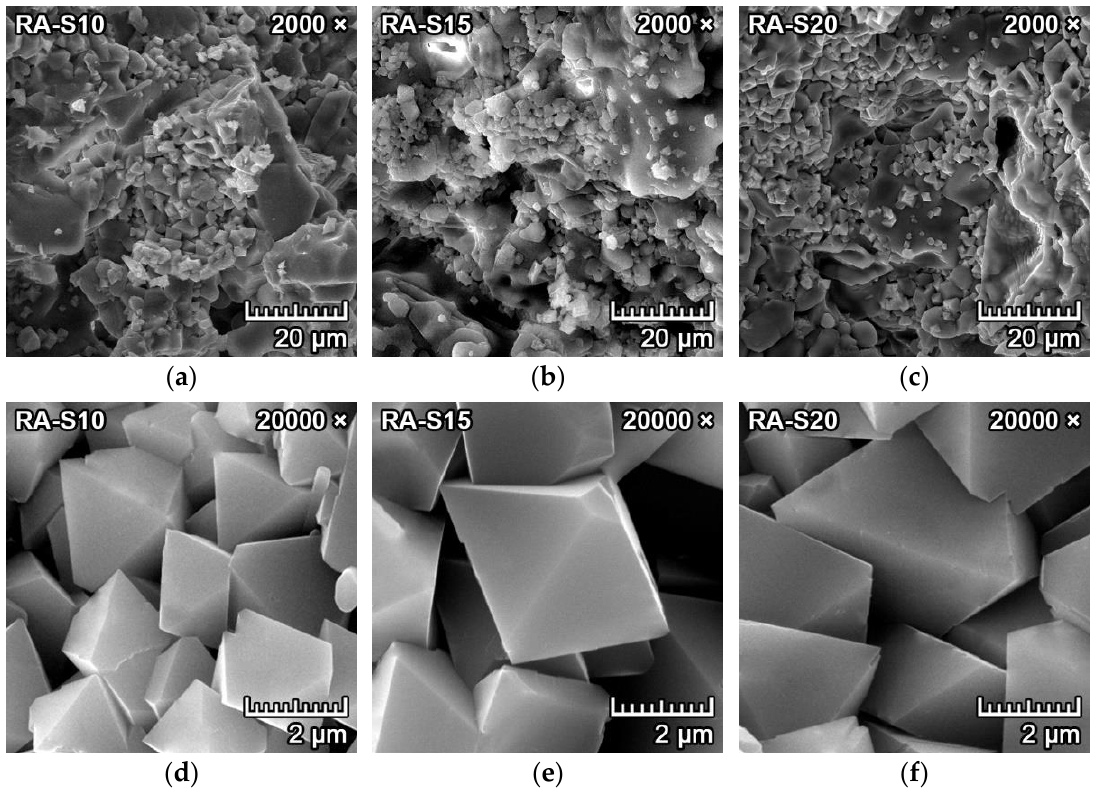
Figure 5. SEM images of fired forsterite – spinel ceramics mixtures with reactive alumina (RA-S10, S15, S20) with a magnification of 2000× ( a – c ) and 20000× ( d – f ).